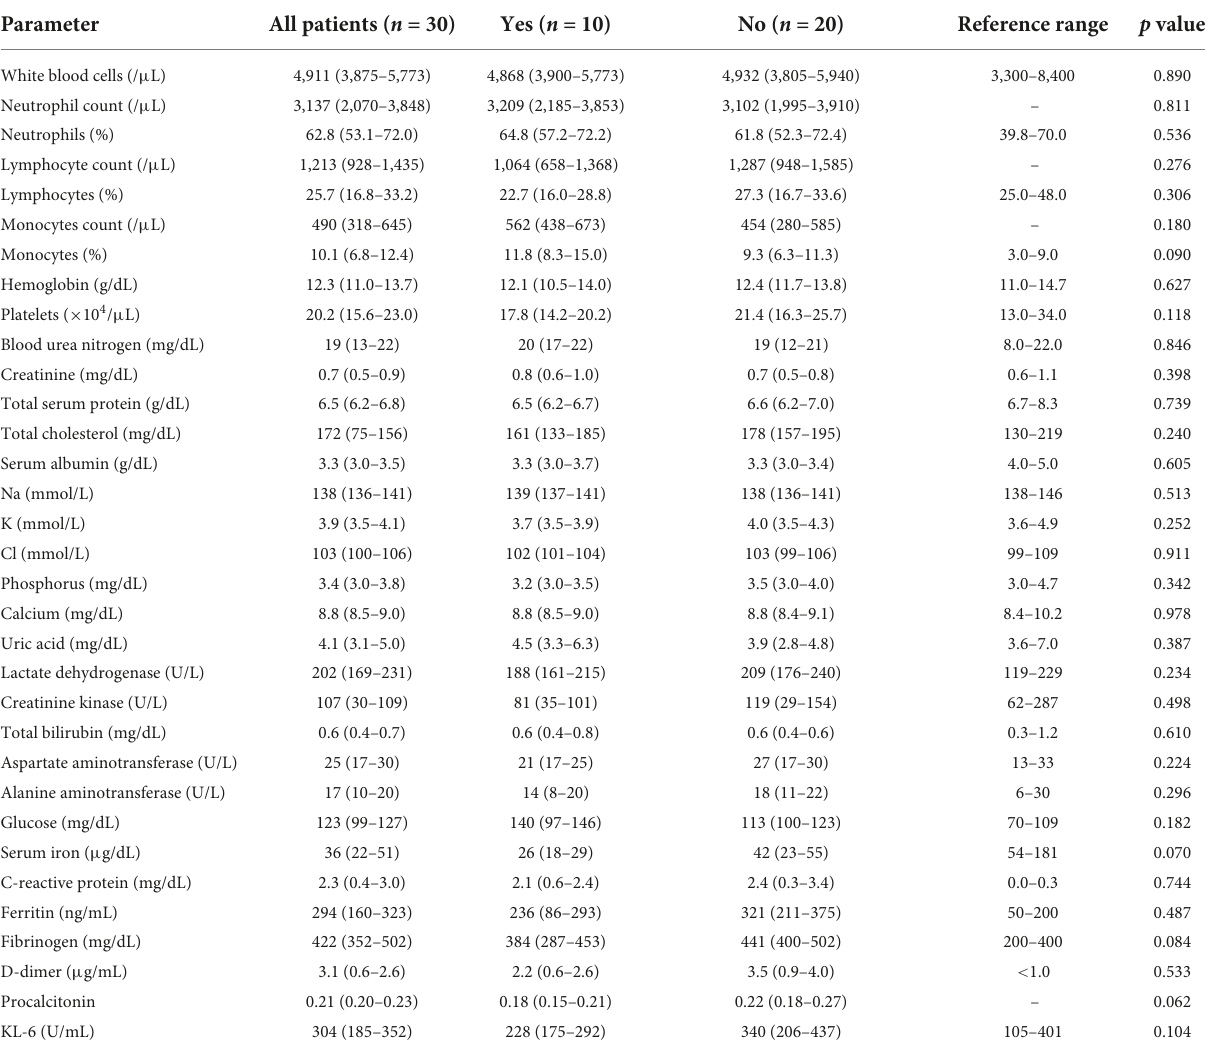
TABLE 2 Laboratory findings of patients with COVID-19 based on local non-image